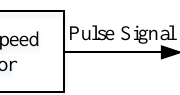
Figure 4. Function diagram for the rotor speed sensor model.